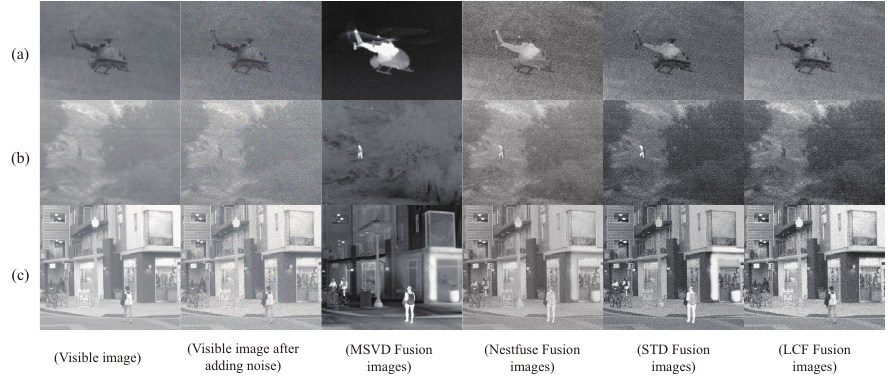
Figure 10. Comparison of fusion results after adding noise. The pabels of ( a – c ) are three different images respectively. From left to right, each row is as follows: Visible image. visible image after adding noise. Fused image of MSVD. Fused image of NestFuse. Fused image of STD. Fused image of